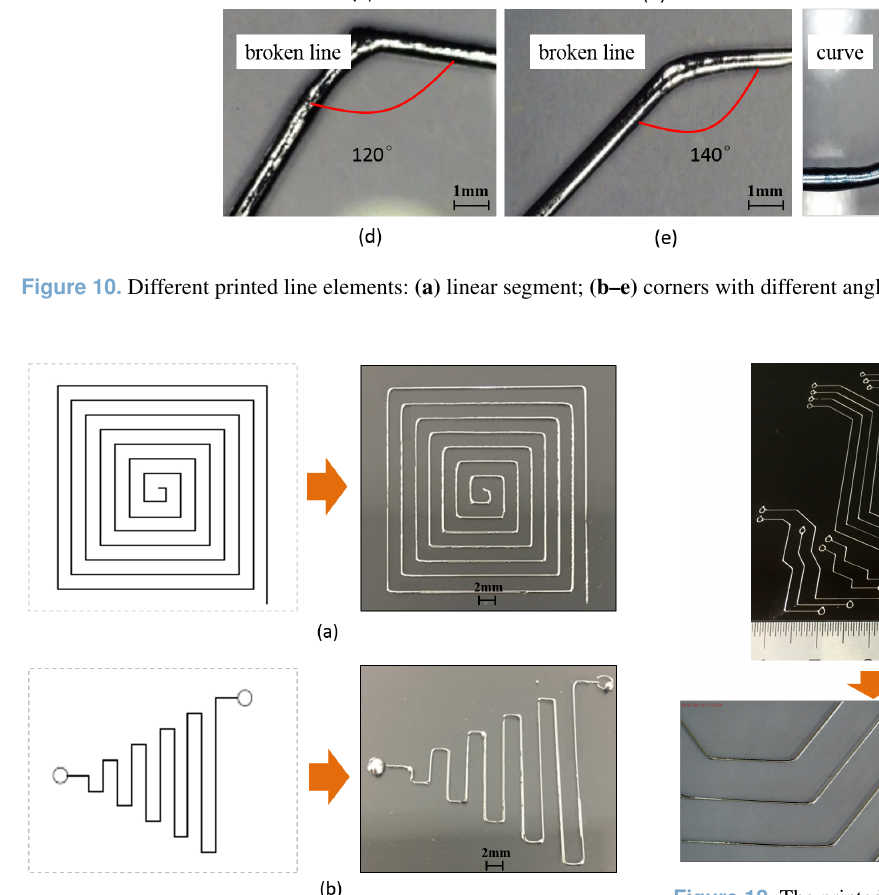
Figure 11. The printed graphic patterns on PVC film substrates: (a) inductance coil; (b) miniature antenna.